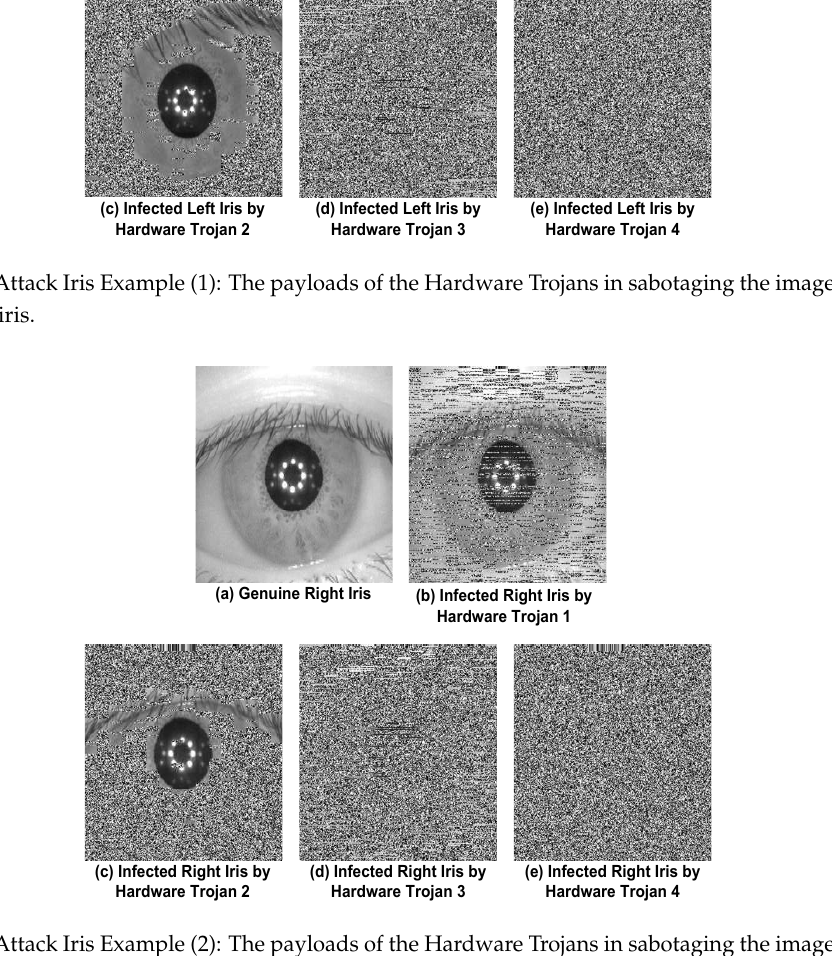
Figure 9. Attack Iris Example (2): The payloads of the Hardware Trojans in sabotaging the image prints of the right